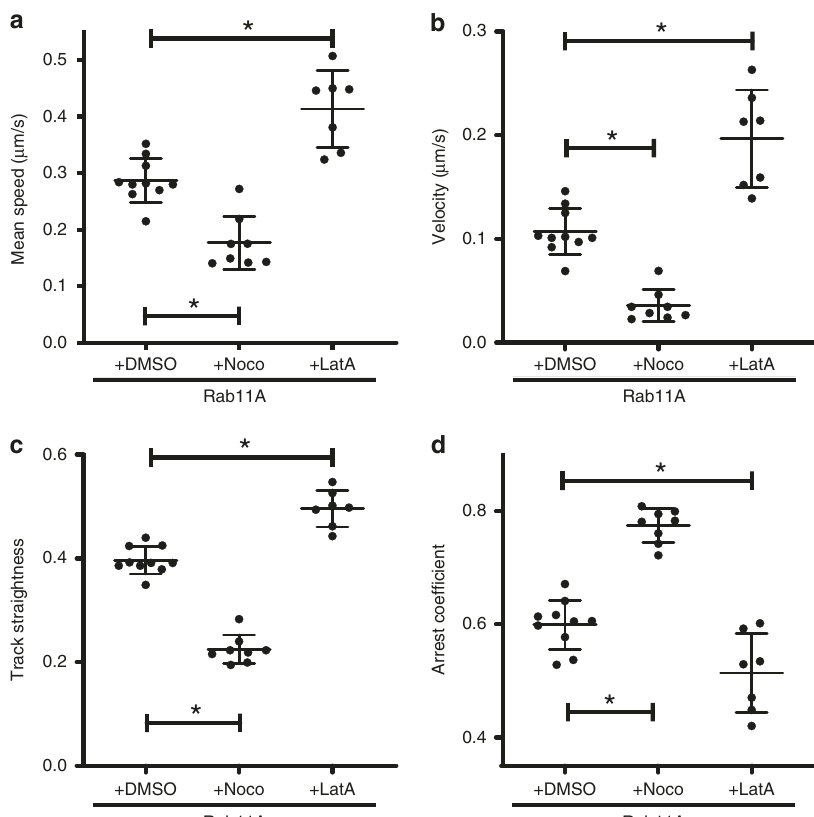
Fig. 3 Motion dynamics of Rab11A under the effect of cytoskeletal depolymerizing drugs. A549 stable cells expressing GFP-Rab11A were treated with nocodazole (16 μ M), latrunculin A (1 μ M), or DMSO (control) and imaged 4 h post treatment. Imaging is performed at 37 °C on a temperature-controlled stage. Each datapoint represents an individual cell (DMSO: n = 10 cells, nocodazole: n = 8 cells, and latrunculin A: n = 7 cells) using CF 50 for the corresponding motion parameters: a track mean speed, b track mean velocity, c track straightness, and d track arrest coef fi cient. Image processing and analysis were performed as described in the “ Methods ” section. Mean ± standard deviation (SD) is shown per group (* implies p < 0.05, comparisons performed using one-way ANOVA with Tukey ’ s multiple tests). Source data are provided as a Source Data fi